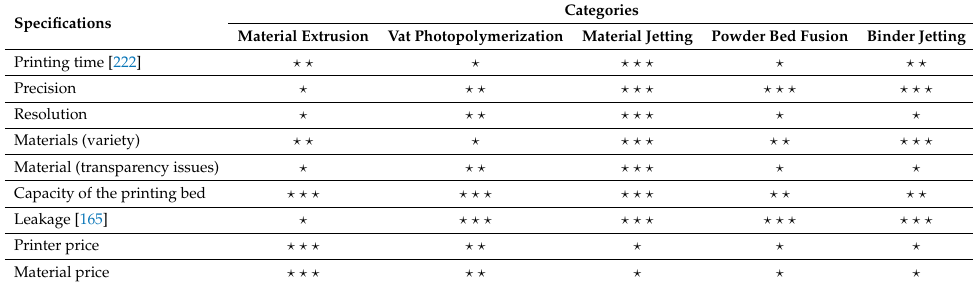
Table 5. 3D printing category specifications that best suit ( (cid:63) (cid:63) (cid:63) ), ( (cid:63) (cid:63) ) intermediate suit or not ( (cid:63) ) the uses.